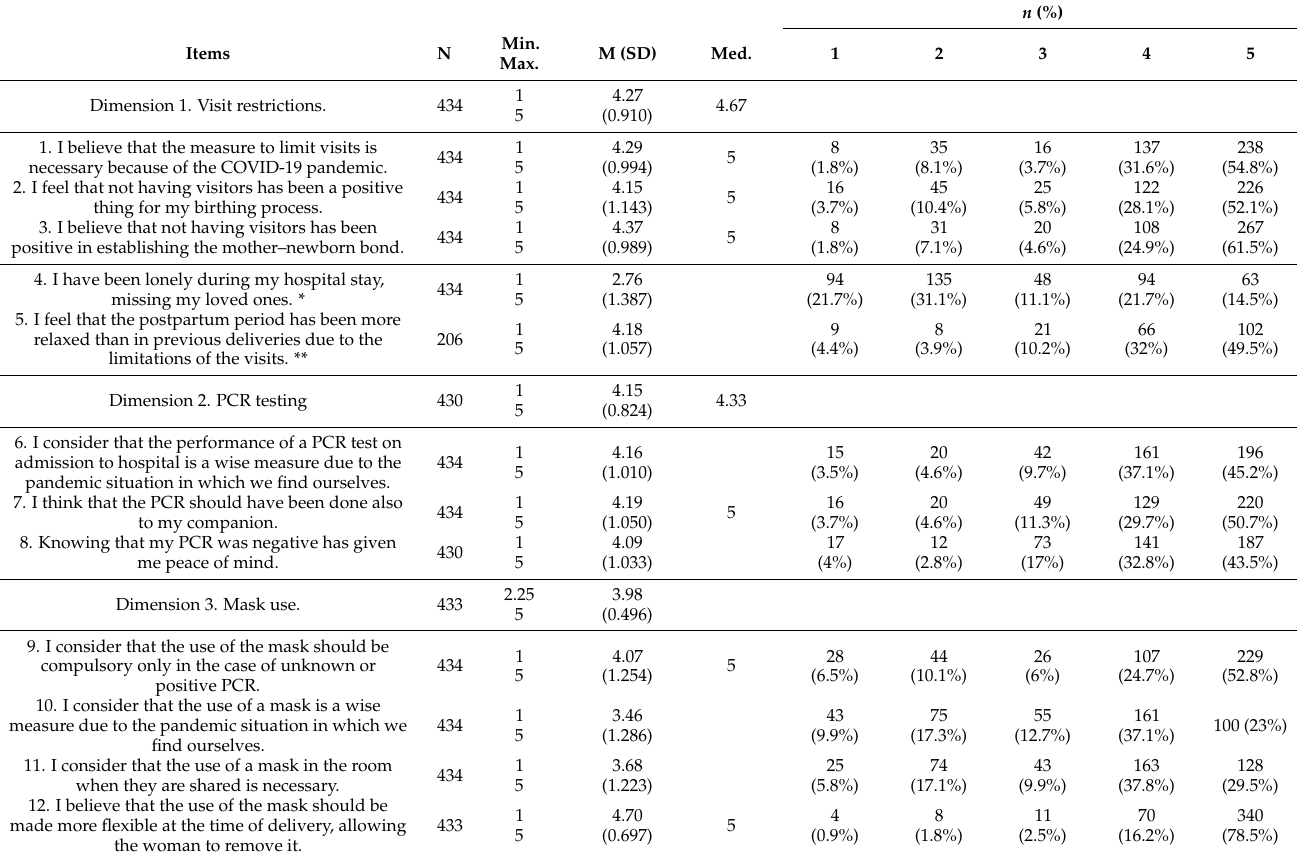
Table 2. Descriptive statistics for the survey items and dimensions.